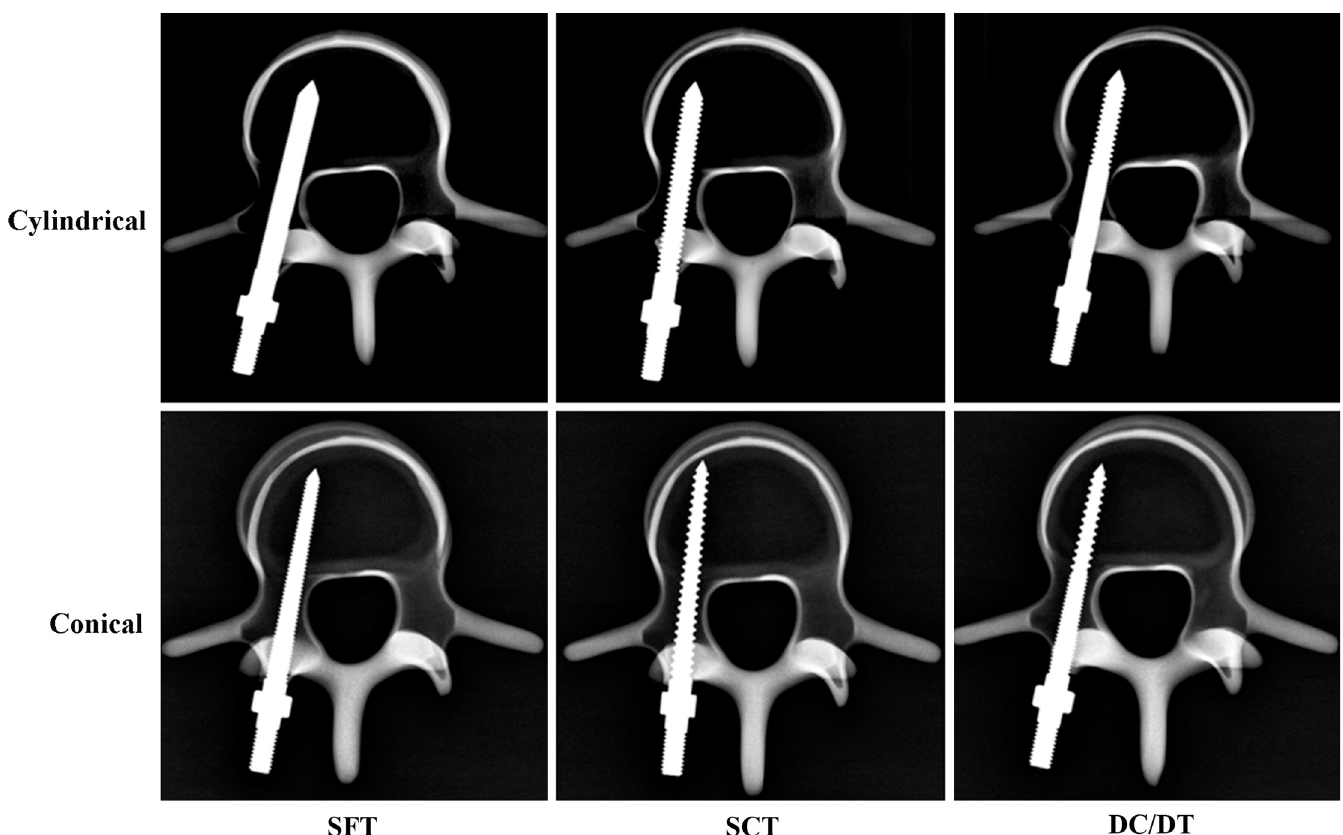
Fig 3. Radiological images showing synthetic vertebrae and the inserted solid screws. The radiological examinations indicated that the proximal fine thread in the DC/DT profile is adequately placed within the region of the pedicle cortical bone, whereas the distal coarse threads gained purchase in the cancellous bone within the vertebral